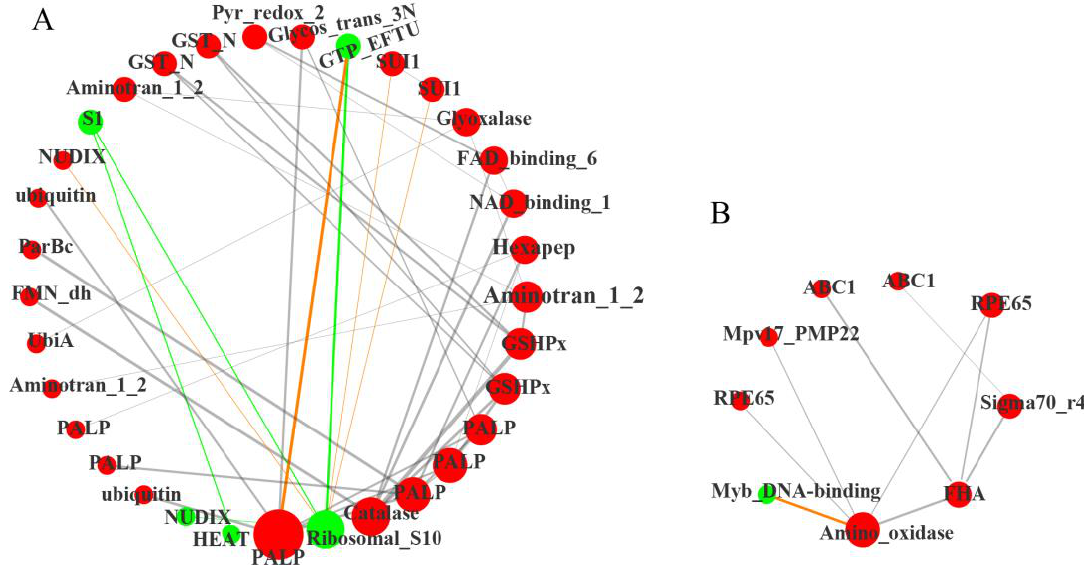
Figure 5. Co-expression network reveals the regulatory of differentially expressed transcription factors (TFs) in MT vs. WT. ( A ) The interaction network of three hub genes (encoding PALP, Catalase and Ribosomal_S10); ( B ) The interaction network of a central gene (encoding Amino_oxidase). The red balls represent the up-regulated expression of TFs in MT, and the green balls represent down-regulated. Orange lines represent negative regulation relationship, gray and green lines represent positive regulation relationship. The size of the node represents the core position of the transcription factor. The width of the connecting line represents the action strength of the corresponding interaction relationship. All the analyses used WT as a control.